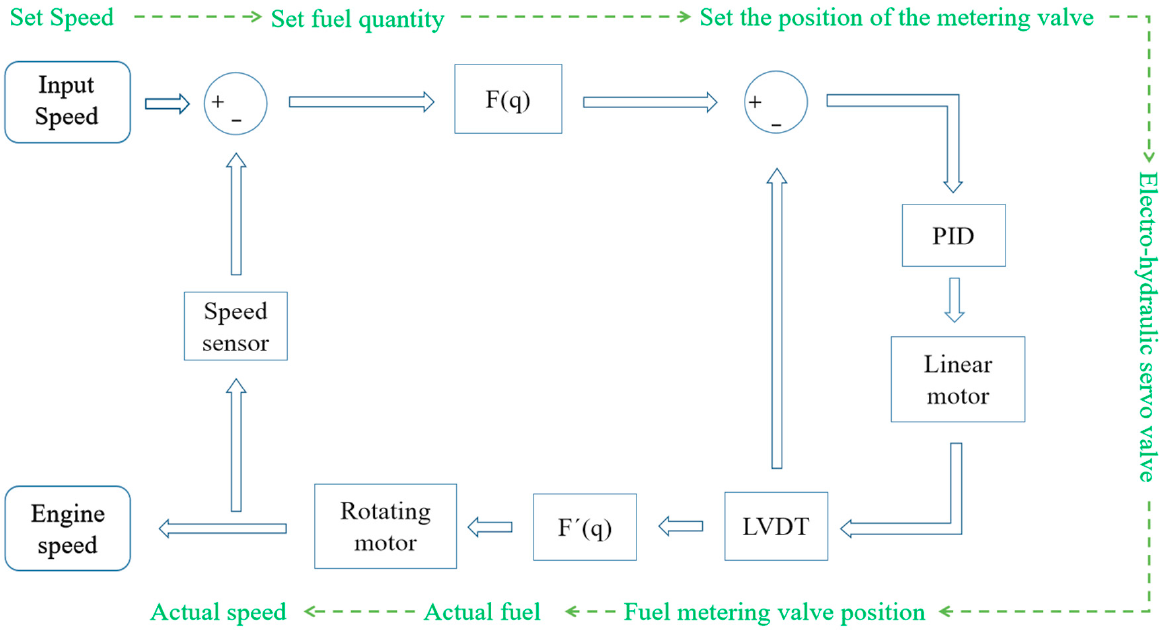
Figure 5. The working principle of the control system.